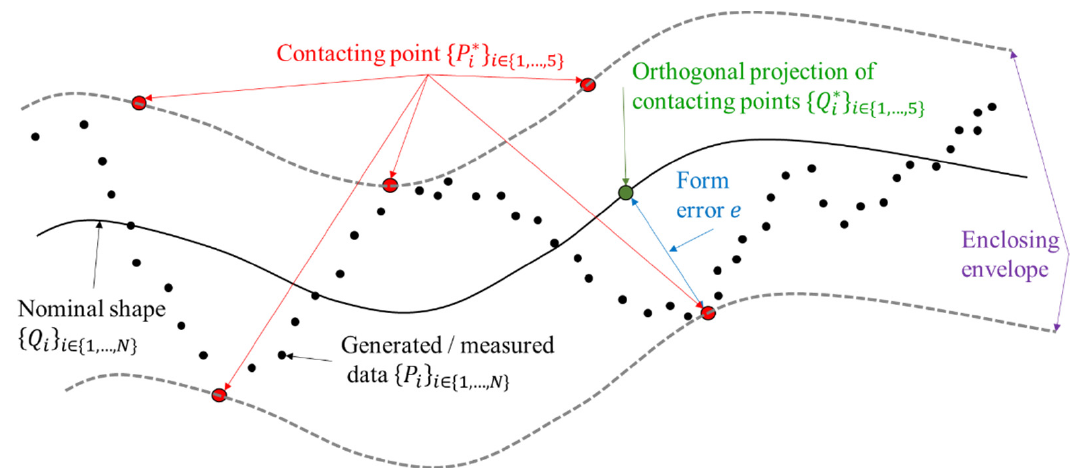
Figure 5. Illustration of five contacting points to the enclosing envelope. Three located on the upper bound and two on the lower bound.